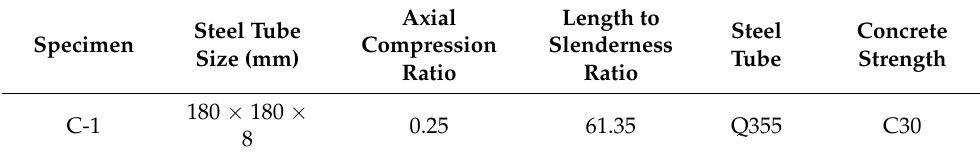
Figure 11. Dimensions of C-1 specimen. Table 5. Parameters of C-1